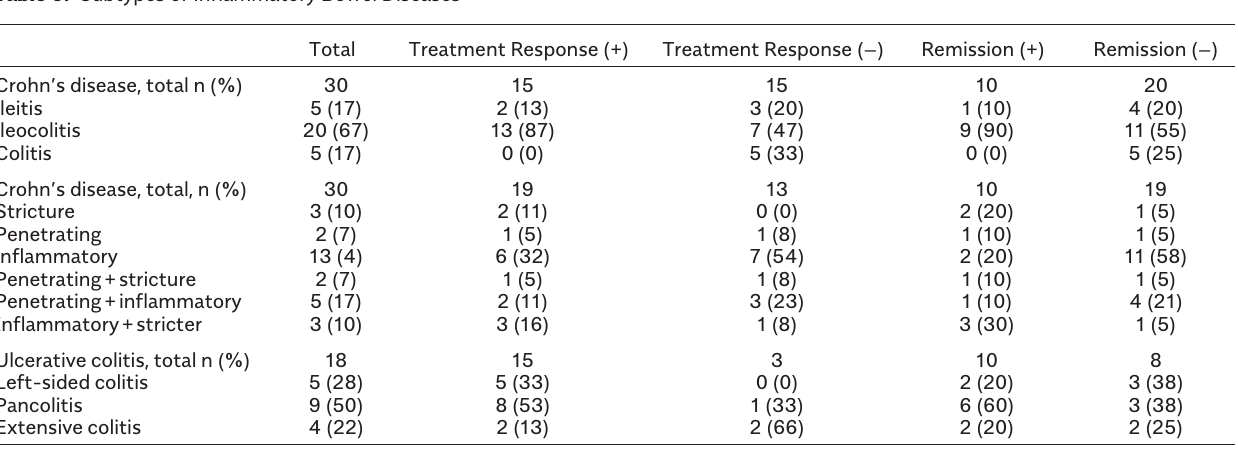
Table 6. Subtypes of Inflammatory Bowel Diseases Total Treatment Response (+) Treatment Response ( −